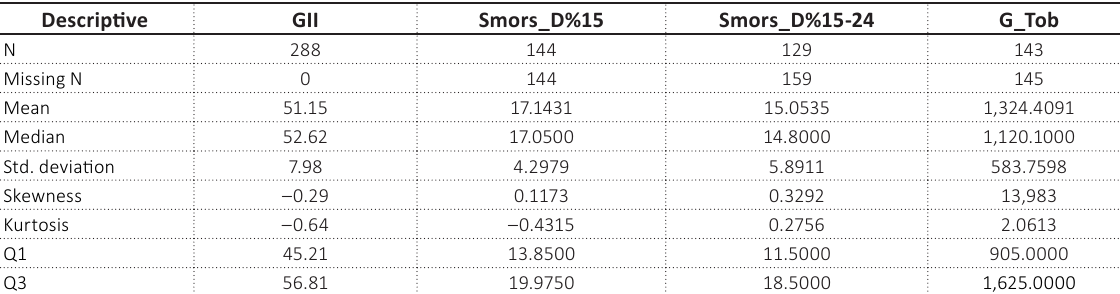
Table 1. Descriptive statistics of